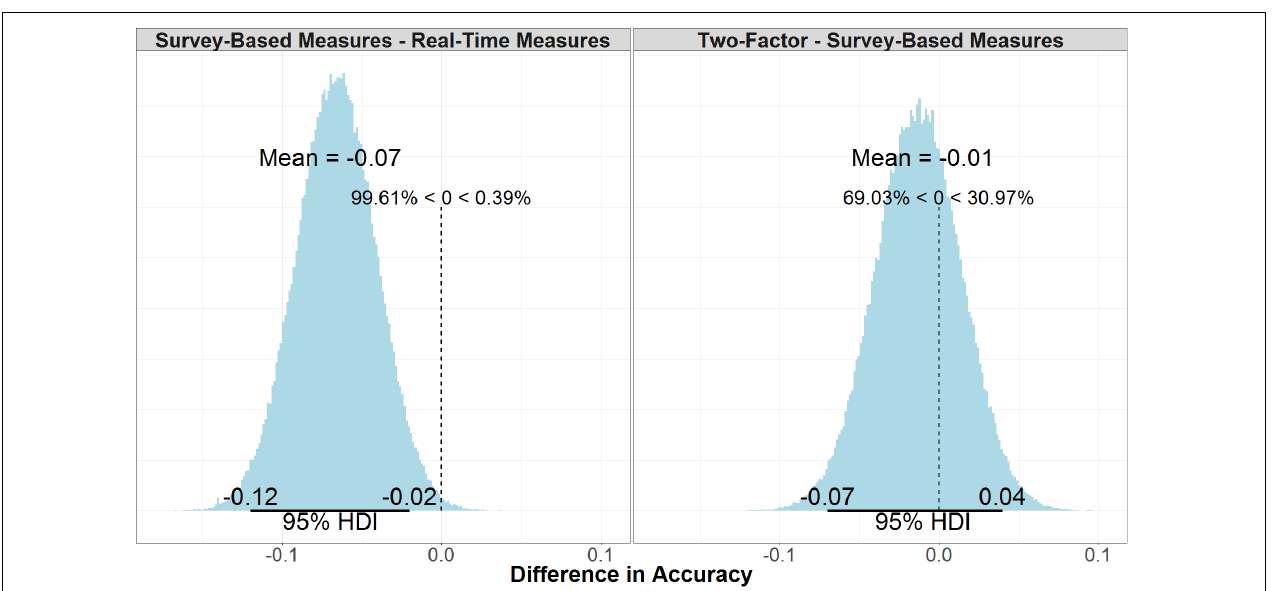
FIGURE 11 | Comparison of accuracy for survey-based and real-time measures models (Left) and two-factor and survey-based models